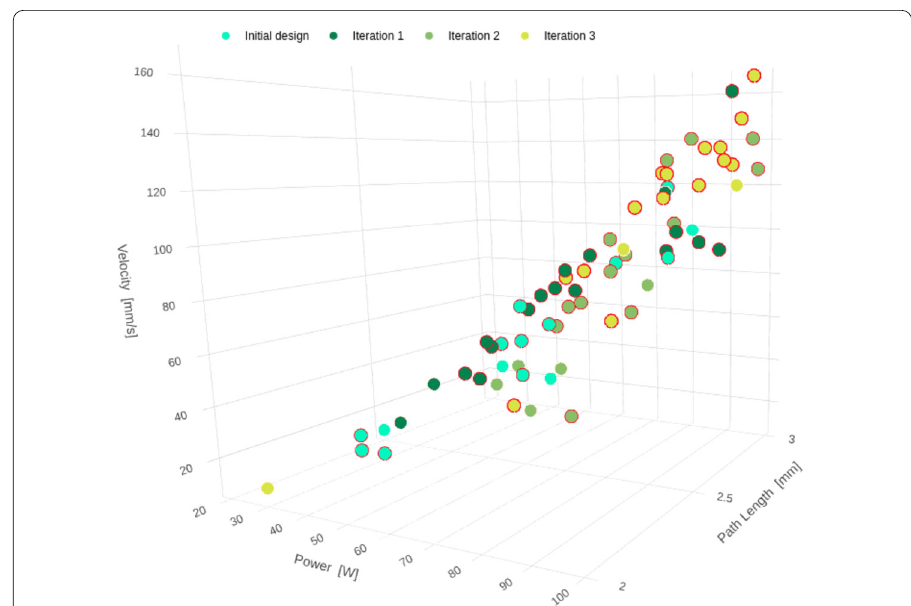
Figure 12 Case Study 2: Values of CPV for the initial experimental design (cyan), iteration k = 1 (dark green), iteration k = 2 (olive green), and iteration k = 3 (yellow). The red circle around the dots mark the runs belonging to the final Pareto